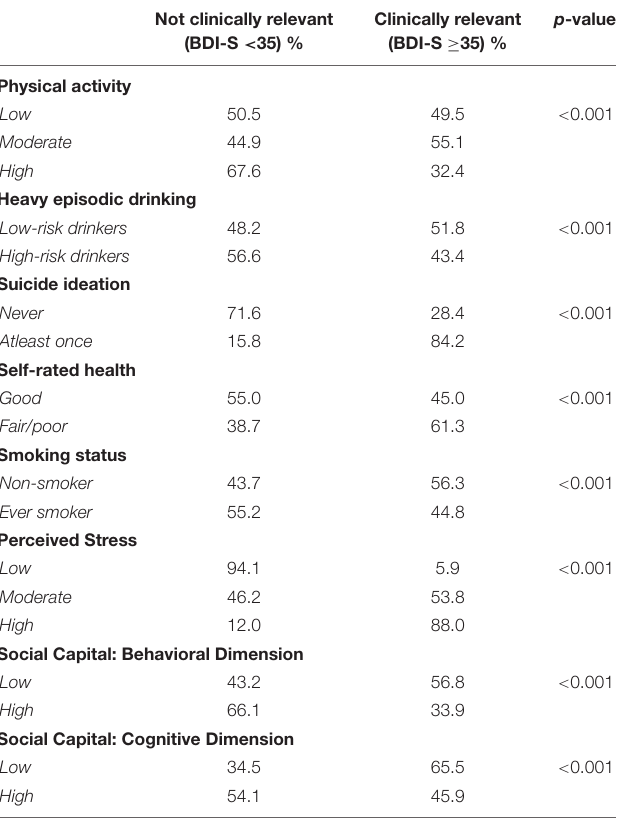
TABLE 2 | Health-related behavior among university students with and without depressive symptoms ( N = 4228). Not clinically relevant Clinically relevant (BDI-S < 35) % (BDI-S ≥ 35)